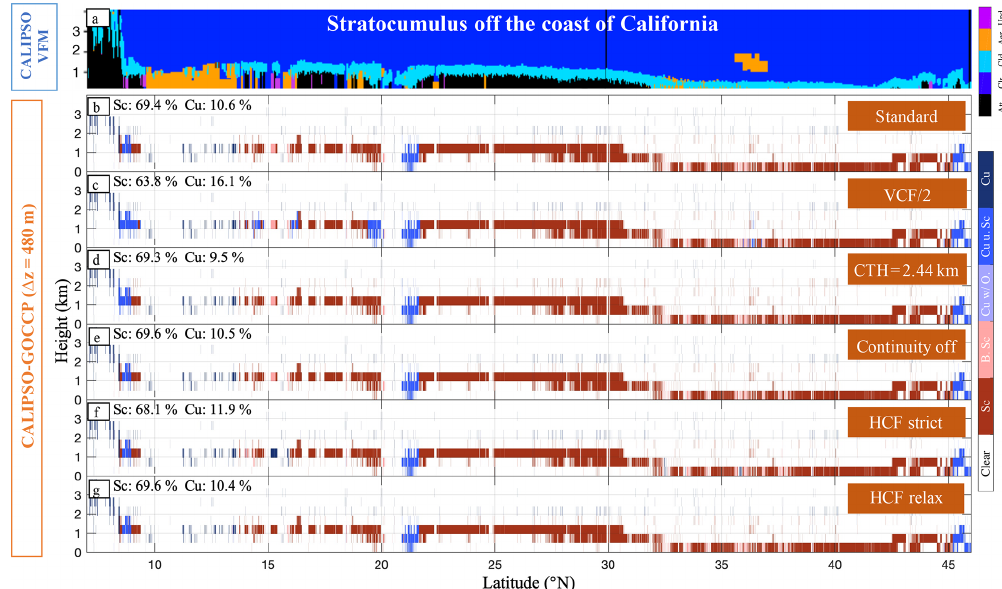
Figure 6. Daytime orbit segment off the coast of California ( ∼ 8 to 46 ◦ N, 8 July 2008 21:47:30) showing a typical stratocumulus case. (a) VFM CALIPSO-ST at 30m vertical resolution; (b) to (g) sensitivity of the GOCCP Sc–Cu mask to different DA parameters: (b) the VCF threshold is divided by 2, (c) the CTH threshold is elevated from 1.92 to 2.4km, (d) standard DA parameters, (e) the continuity test is turned off, (f) the 10 and 20km HCF thresholds are more conservative (i.e., increased by 0.1, absolute value), and (g) the 10 and 20km HCF thresholds are less conservative (i.e., decreased by 0.1, absolute value). The HCF of Sc-dominated (including broken Sc) and Cu- dominated (including Cu under Sc and Cu with stratiform outflow) clouds are given in each subplot (top left corner). Reddish and bluish pixels correspond to Sc-dominated and Cu-dominated type of clouds, respectively. From the top to the bottom, the VFM color bar’s labels correspond to undetermined, aerosol, cloudy, clear and fully attenuated pixels. From the top to the bottom, the GOCCP Sc–Cu mask color bar’s labels correspond to cumulus, Cu under Sc, Cu with stratiform outflow, broken Sc, stratocumulus and clear pixels.